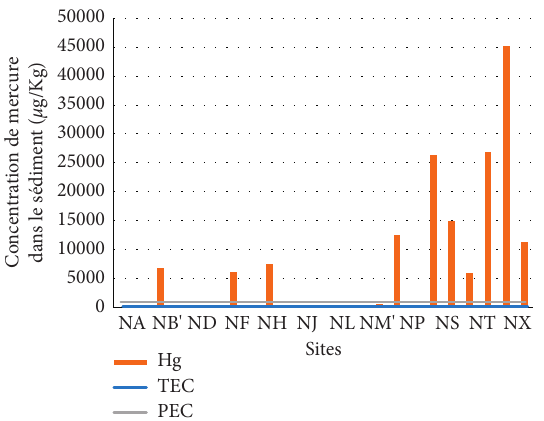
Figure 12: Mercury content in Nokou´e sediments with regard to toxicity